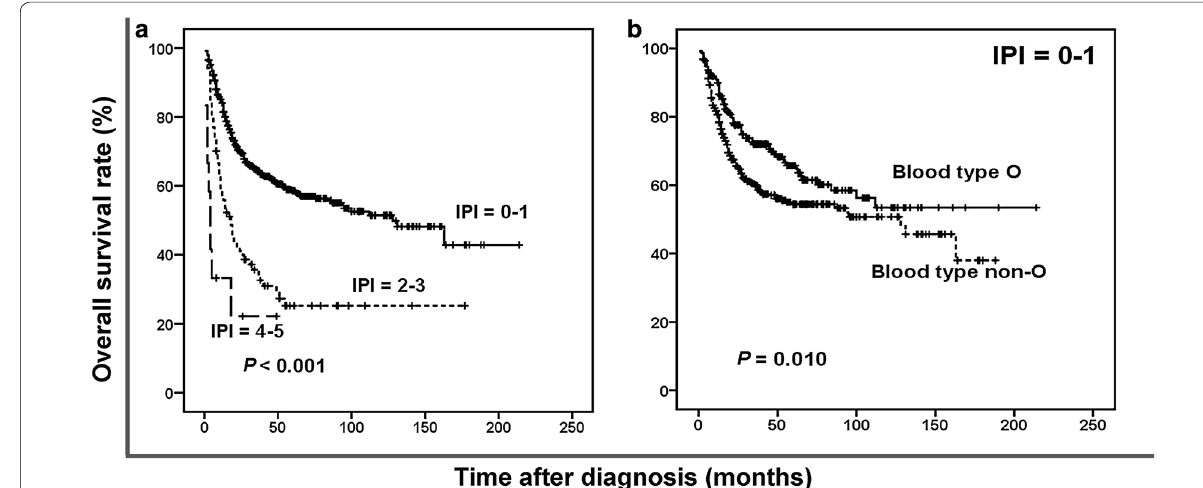
Fig. 2 Survival curves of patients with ENKTL according to the International Prognostic Index (IPI) score. a OS curves of patients according to the IPI. b OS curves of patients with IPI score 0–1 according to blood types O and non‑O =